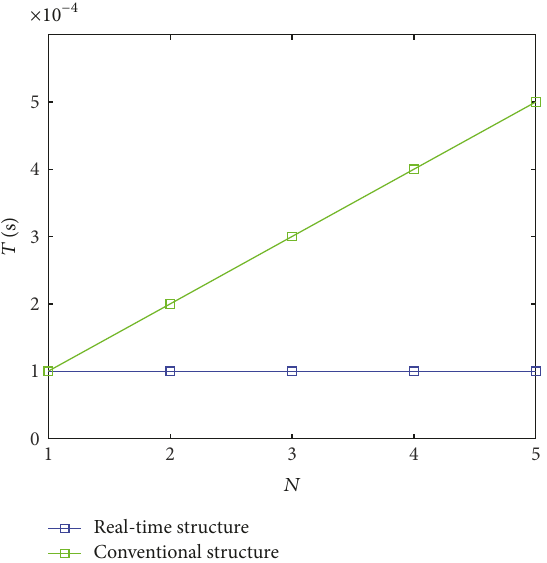
Figure 5: Update time of conventional structure and real-time structure.